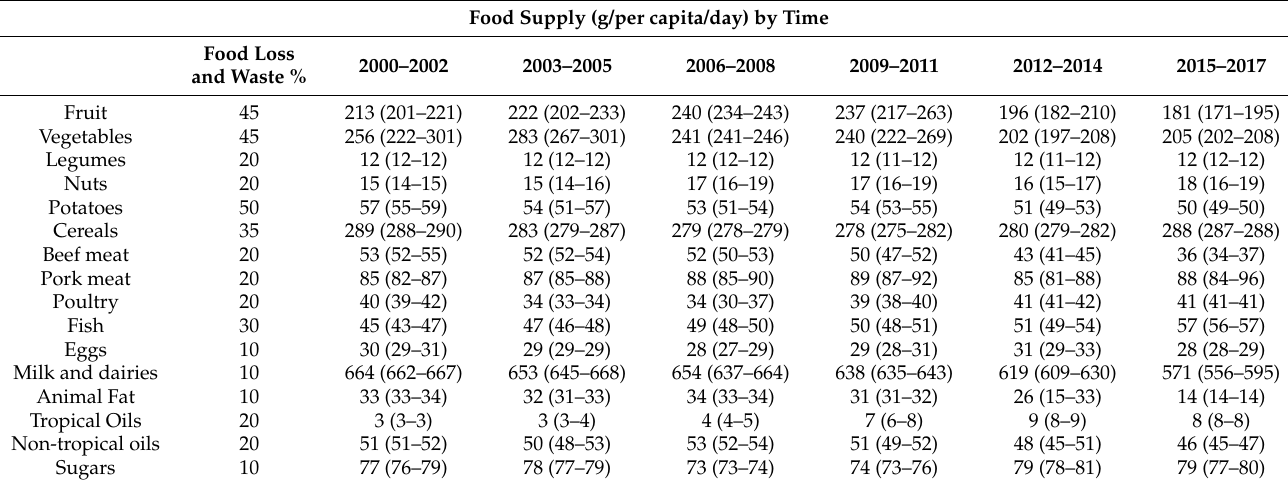
Table 1. Food supply in Italy over time according to the food balance sheets